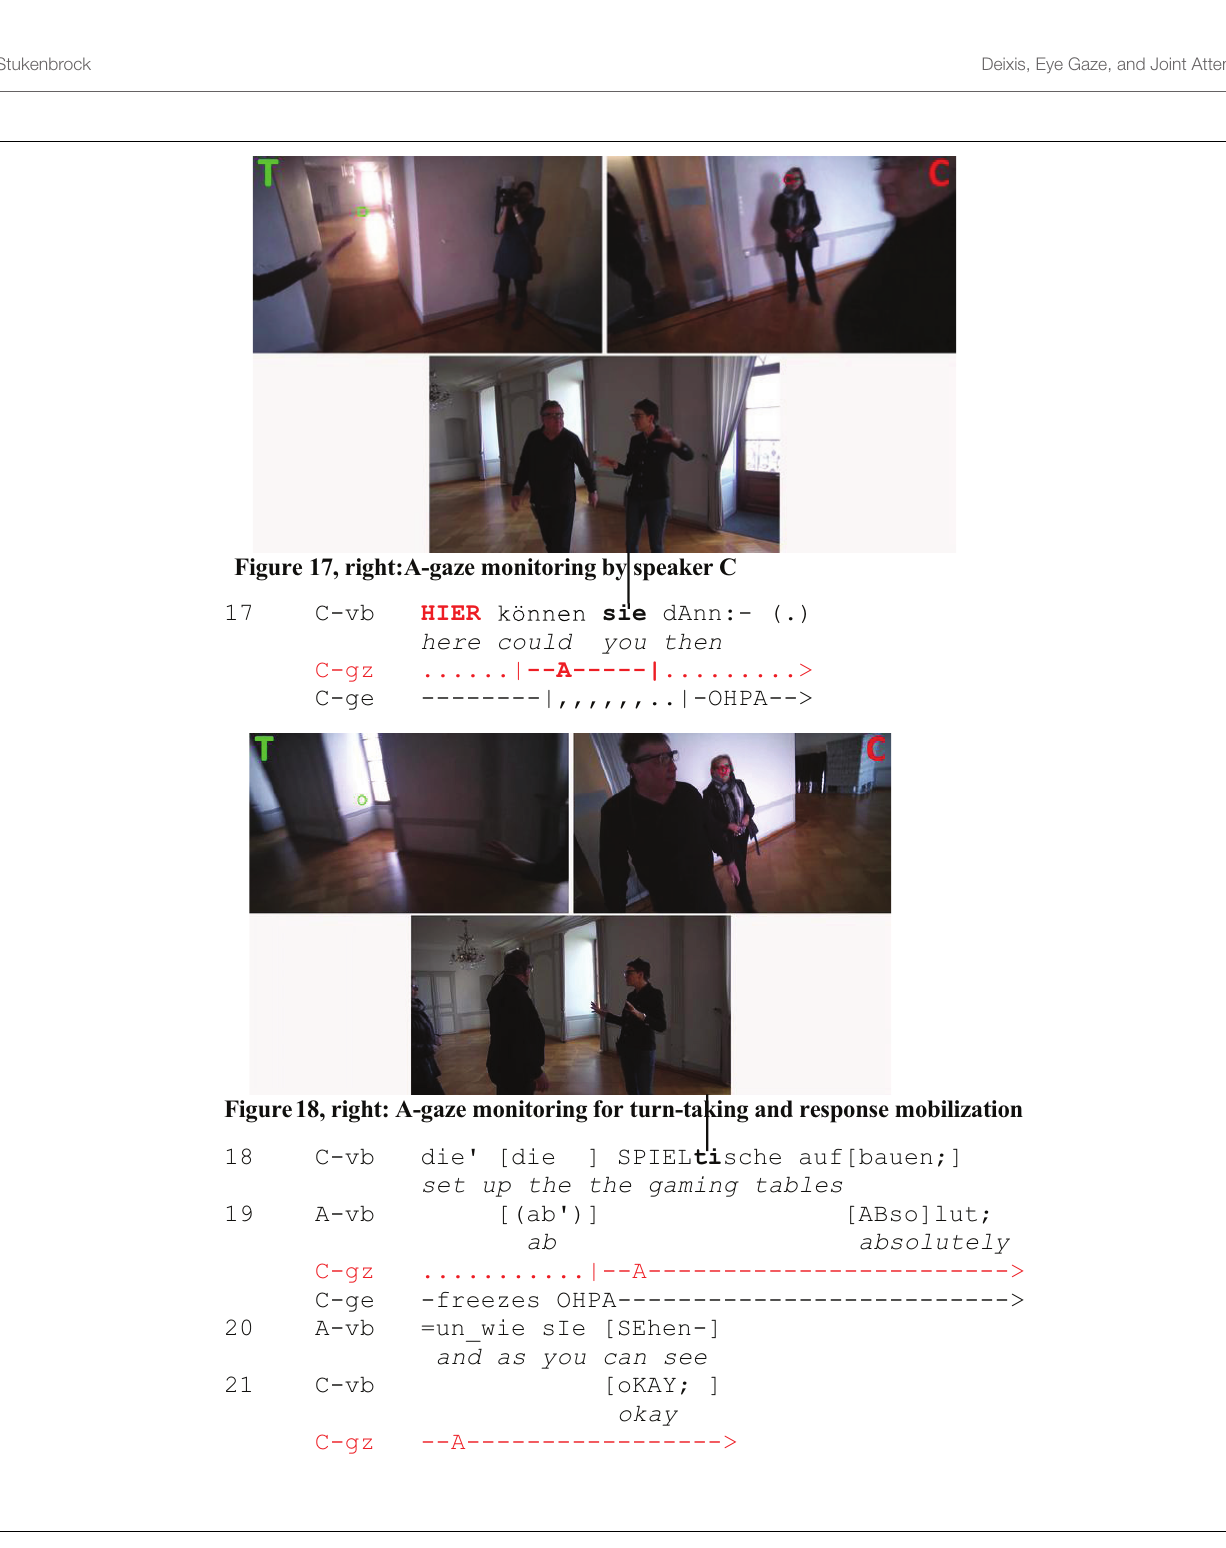
Figure 18, right: A-gaze monitoring for turn-taking and response